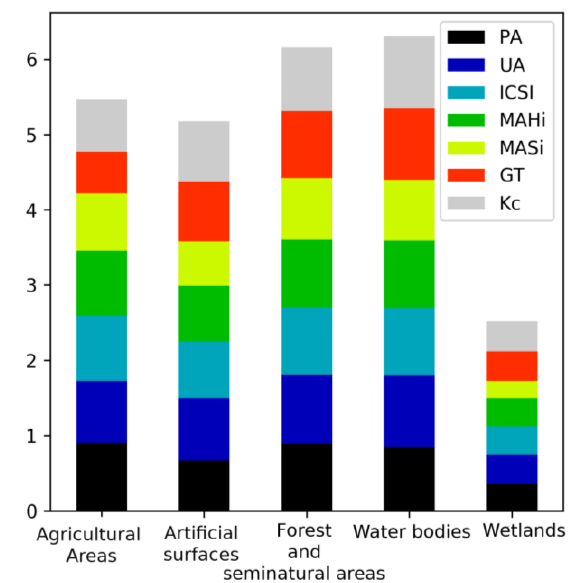
Figure 3. GL30-5 analysis results: per-class indexes (producer’s accuracy PA ; user’s accuracy UA ; Individual Classification Success Index ICSI ; Hellden’s mean accuracy MAHi ; Short’s mean accuracy MASi ; Ground Truth GT ; Conditional Kappa Kc